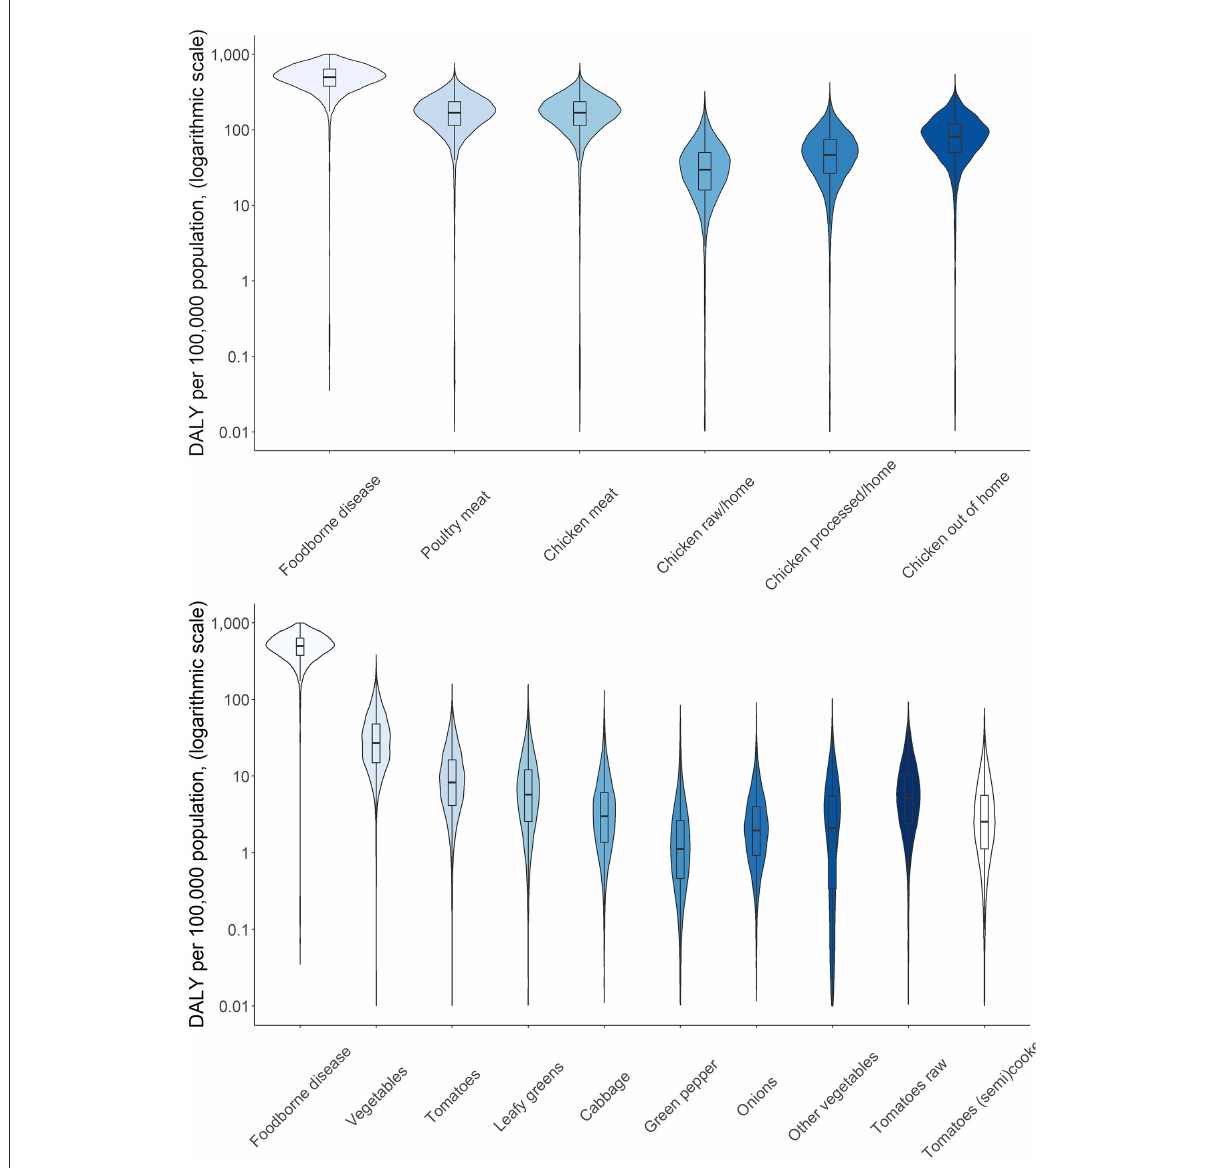
FIGURE5 Attribution of disease burden (Disability-Adjusted Life Years per 100,000 population) of non-typhoidal Salmonella enterica to food types and food products in Burkina Faso in 2017. See Figure 1 for explanation of violin